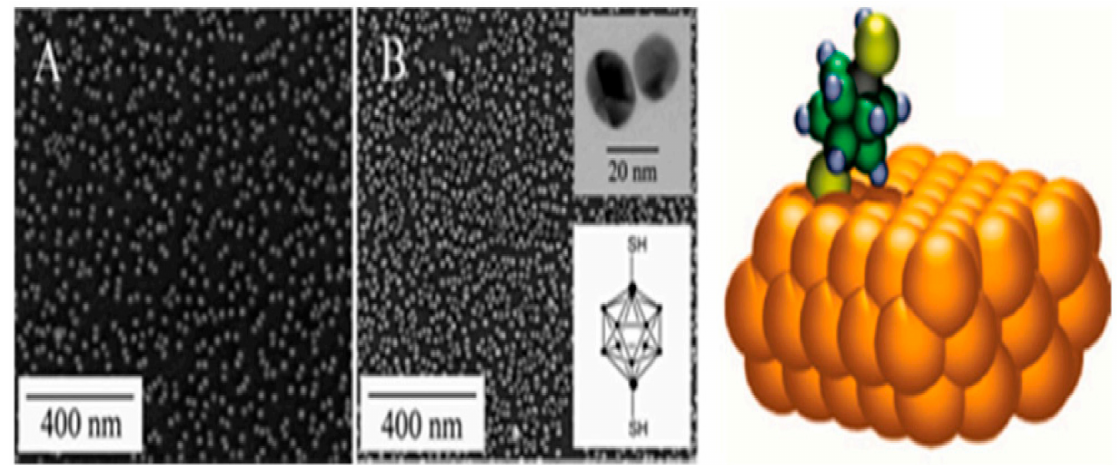
Figure 4. TEM images ( A , B ) of the Au NPs functioned on the capture of the same carboranethiol design on the Au(111) region, functional with the carboanethiol 1,12-(HS)2-1,12-C2 B10 H10. ACS, 2008, reproduced with reference permission